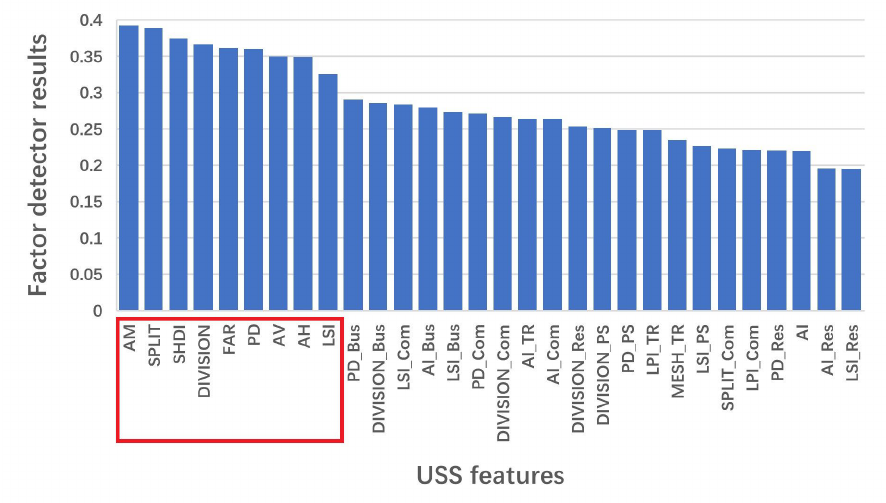
Figure 7. The factor detector results of USS features on NTLI.